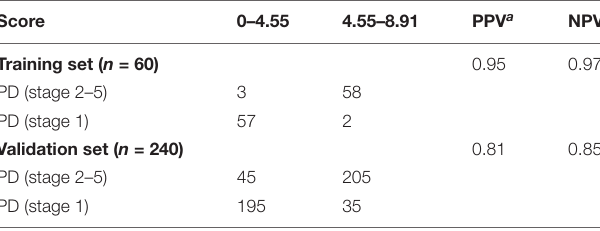
TABLE 3 | Risk score analysis of in PD with different stages.